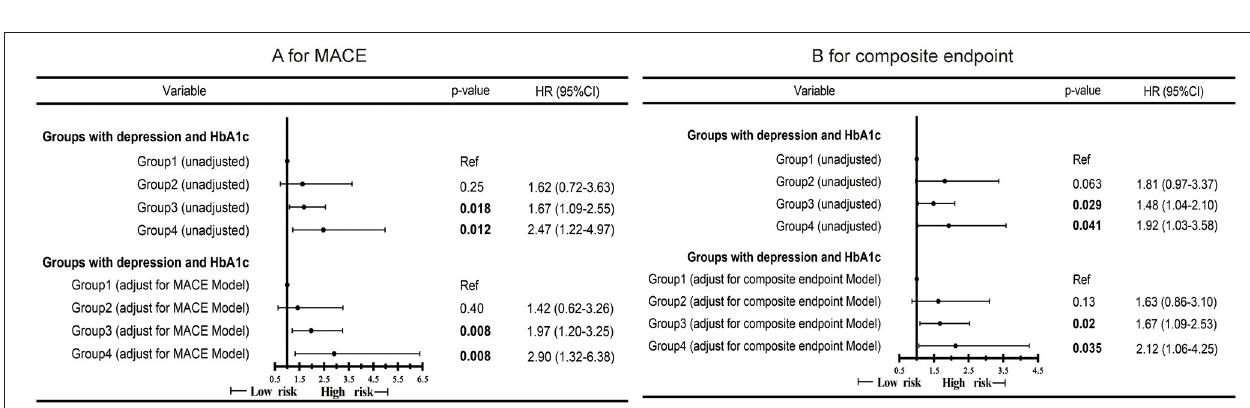
FIGURE 2 | Cox proportional hazard ratios for MACE (A) and composite endpoint (B) by the four groups of all CAD patients in different models. MACE Model: Adjusted for sex, age, severity of coronary artery stenosis, diabetes and HDLC. Composite endpoint Model: Adjusted for sex, age, severity of coronary artery stenosis, diabetes and